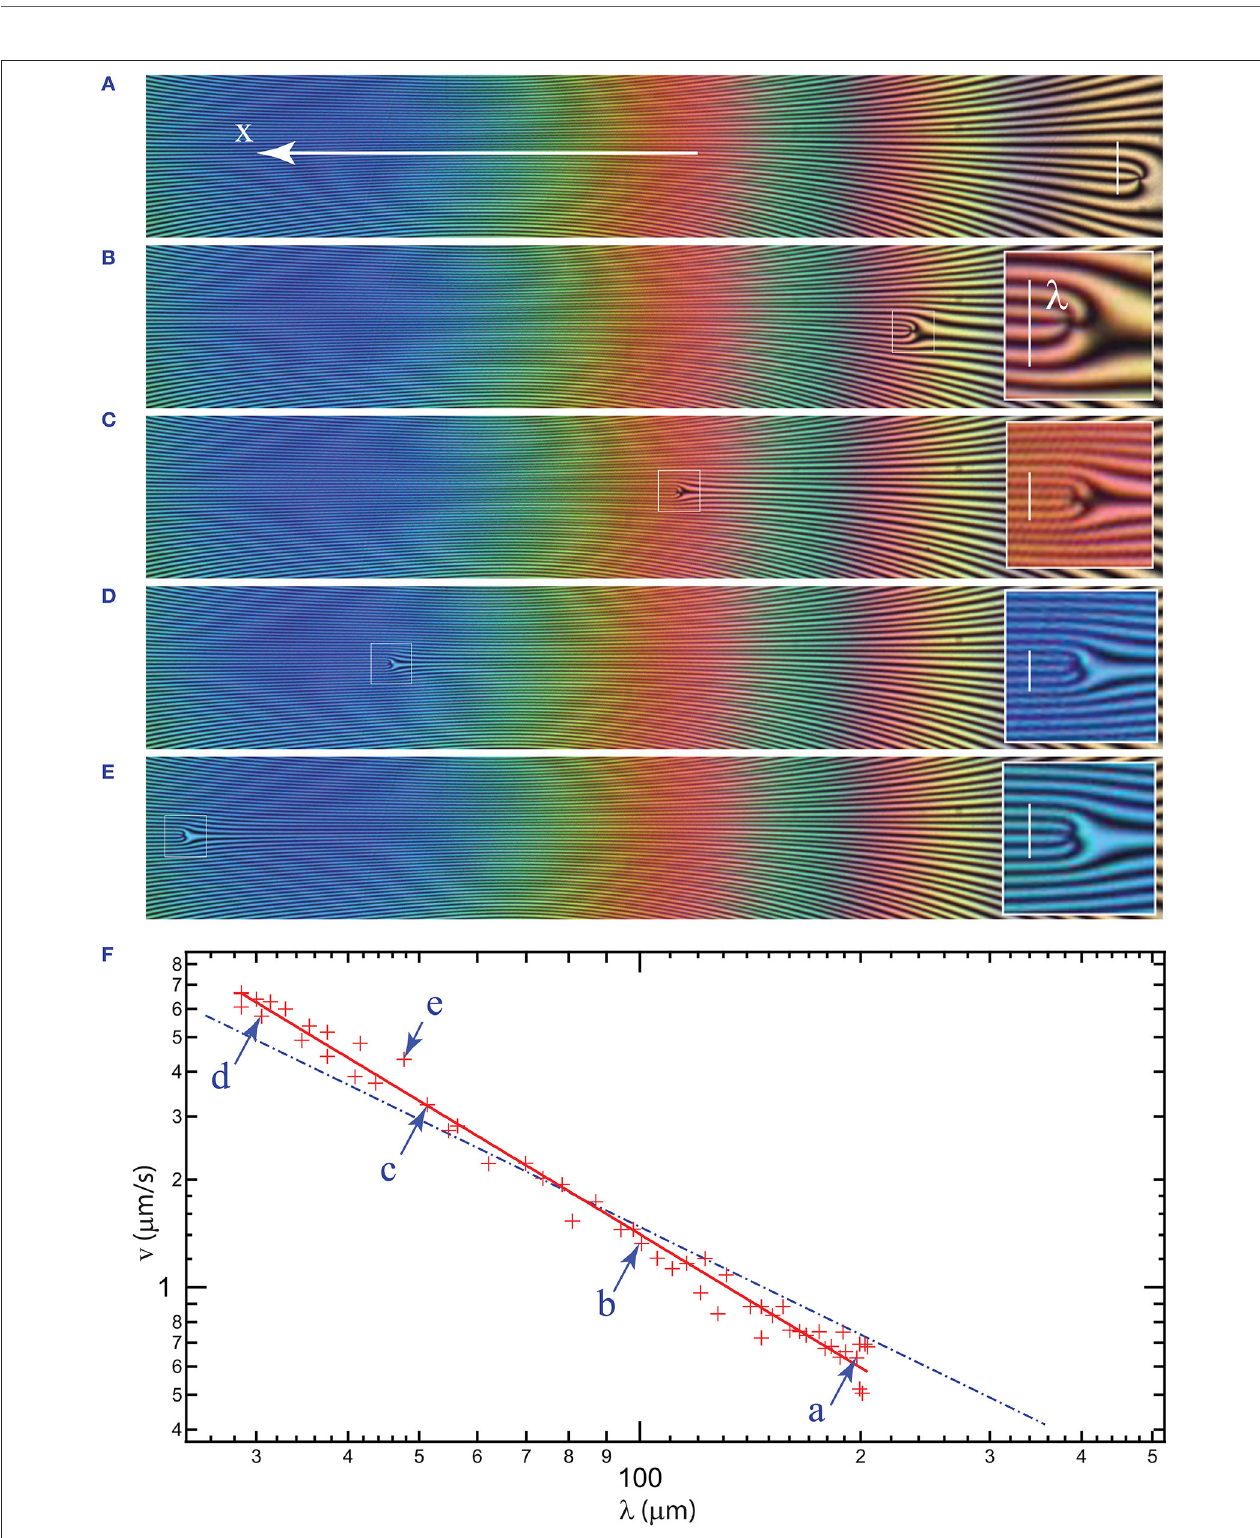
FIGURE 5 | Motion of the dowson d + in the phase gradient generated in the dowson collider DDC. The series of five pictures shows successive positions of the dowson d + at: (A) t = 0 s, (B) t = 380 s, (C) 520 s, (D) 620 s, and (E) 700 s. For a better visibility, small areas in vicinity of the dowson have been enlarged in pictures (B–E) . (F) Plot of the velocity of the dowson d + vs. the local wave length of the wound up dowser texture. The continuous red line represents the fit to the power law v = A λ α with α = − 1.24. The dashed blue line corresponds to α = − 1.